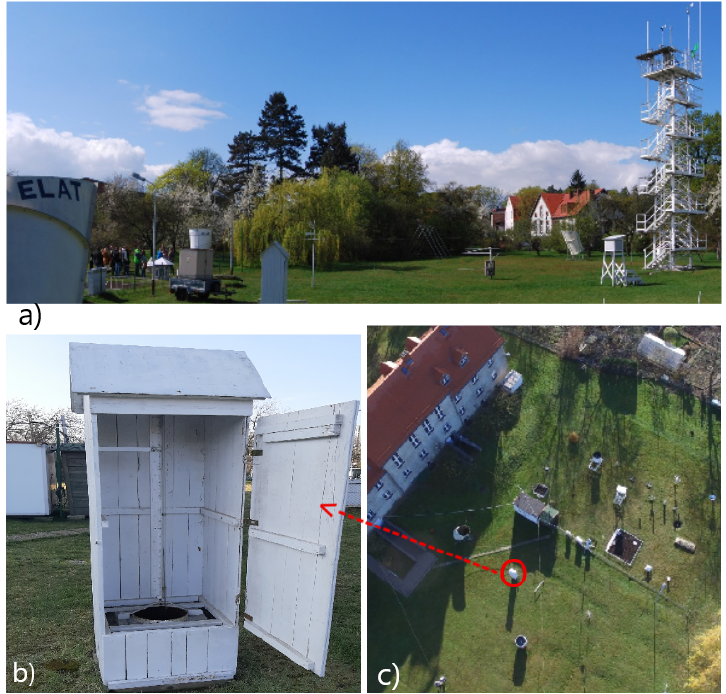
Figure 3. Panoramic view of ’garden-lab’ ( a ) and location of the piezometer ( b , c